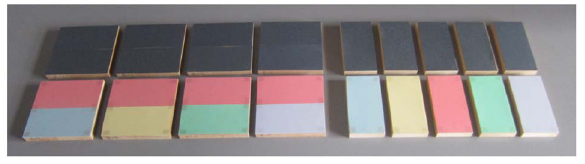
Figure 1. Stimuli. The stimuli were attached to wooden plates (50 6 100 6 12 mm). The sandpapers in the upper row belong to the rough group and the lower sandpapers belong to the smooth group. Left: in order for the participant to be able to quickly switch between stimuli, pairs of stimuli were prepared for the discrimination task. Different roughnesses have different colors in the smooth group.